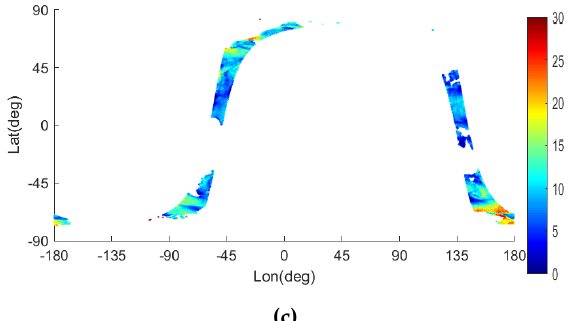
Figure 8. Wind speed of ground the L2 product ( a ) and that of on-board procedure in a full resolution geophysical modelling function (GMF) LUT ( b ) and a desampled GMF LUT ( c ). Color indicates wind speed in m/s.